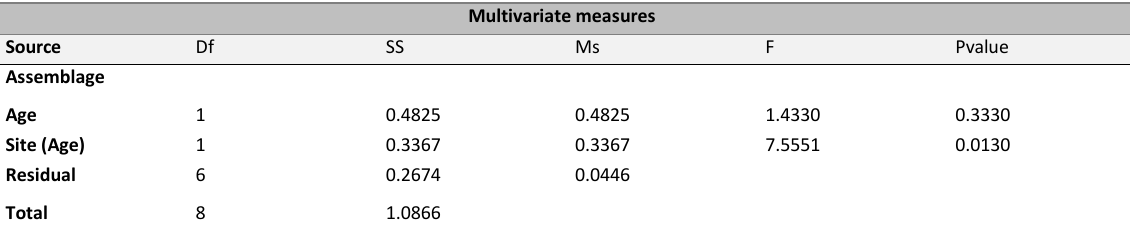
Table 3: Results of multivariate NP-Manova testing the interactive effects of the age (of deployment) and site (nested in Age) on the presence/absence assemblage. Sites tested: AGD1 vs (AGD2 vs AGD3). Significant (P<0.05) values in bold.